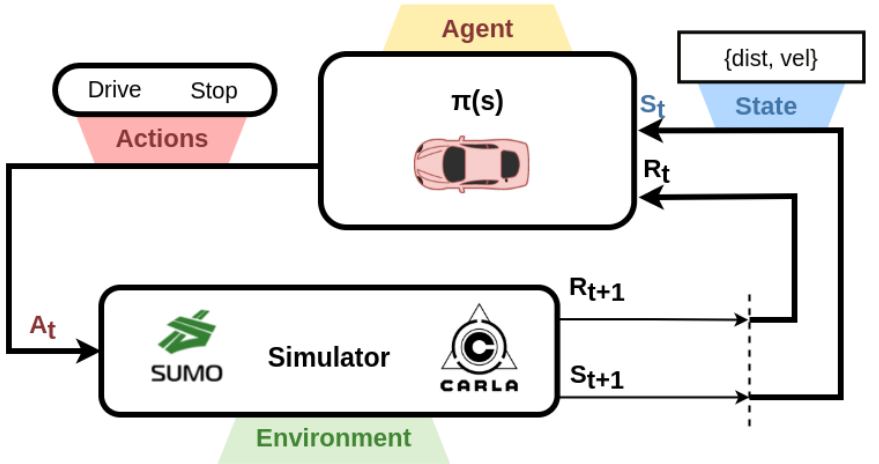
Figure 2. The state vector is extracted from the simulator. The agent selects an action considering this matrix and the reward for this